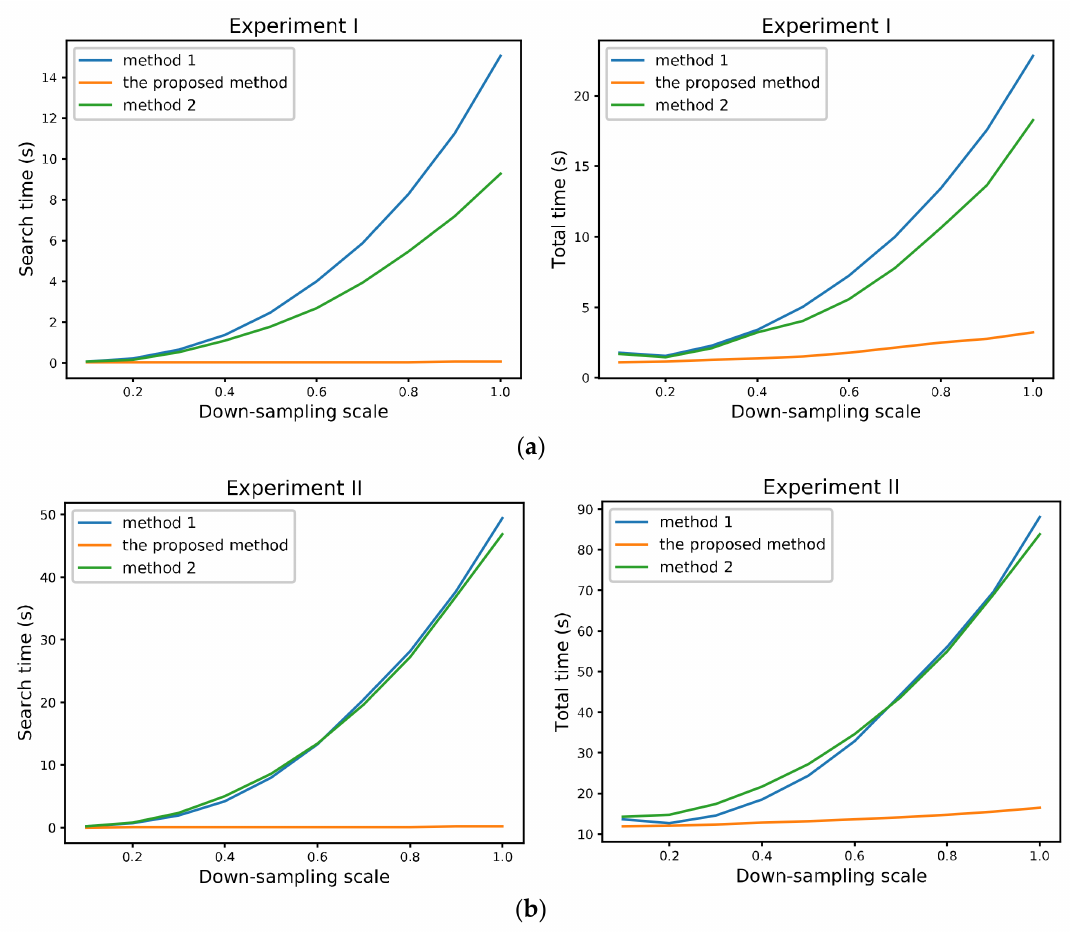
Figure 13. Process time for improved JPS algorithm based on processed DSM (the proposed method), the Dijkstra’s algorithm with difference image (method 1), and the Dijkstra’s algorithm based on processed DSM (method 2) under different pixel resolutions. The overlap images was set to an initial size (shown in Table 1), then they were processed with down-sampling scales (from 1.0 to 0.1) to different pixel resolutions for